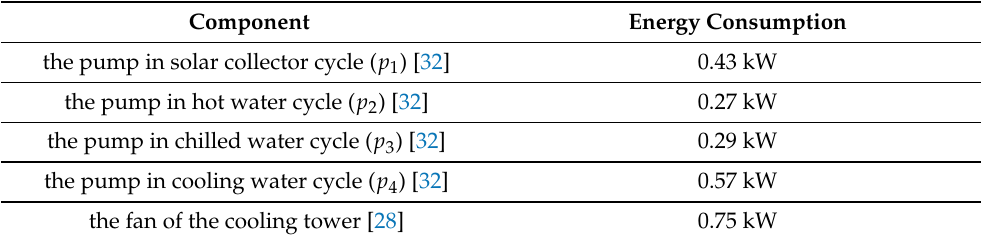
Table 3. Electrical energy consumption.